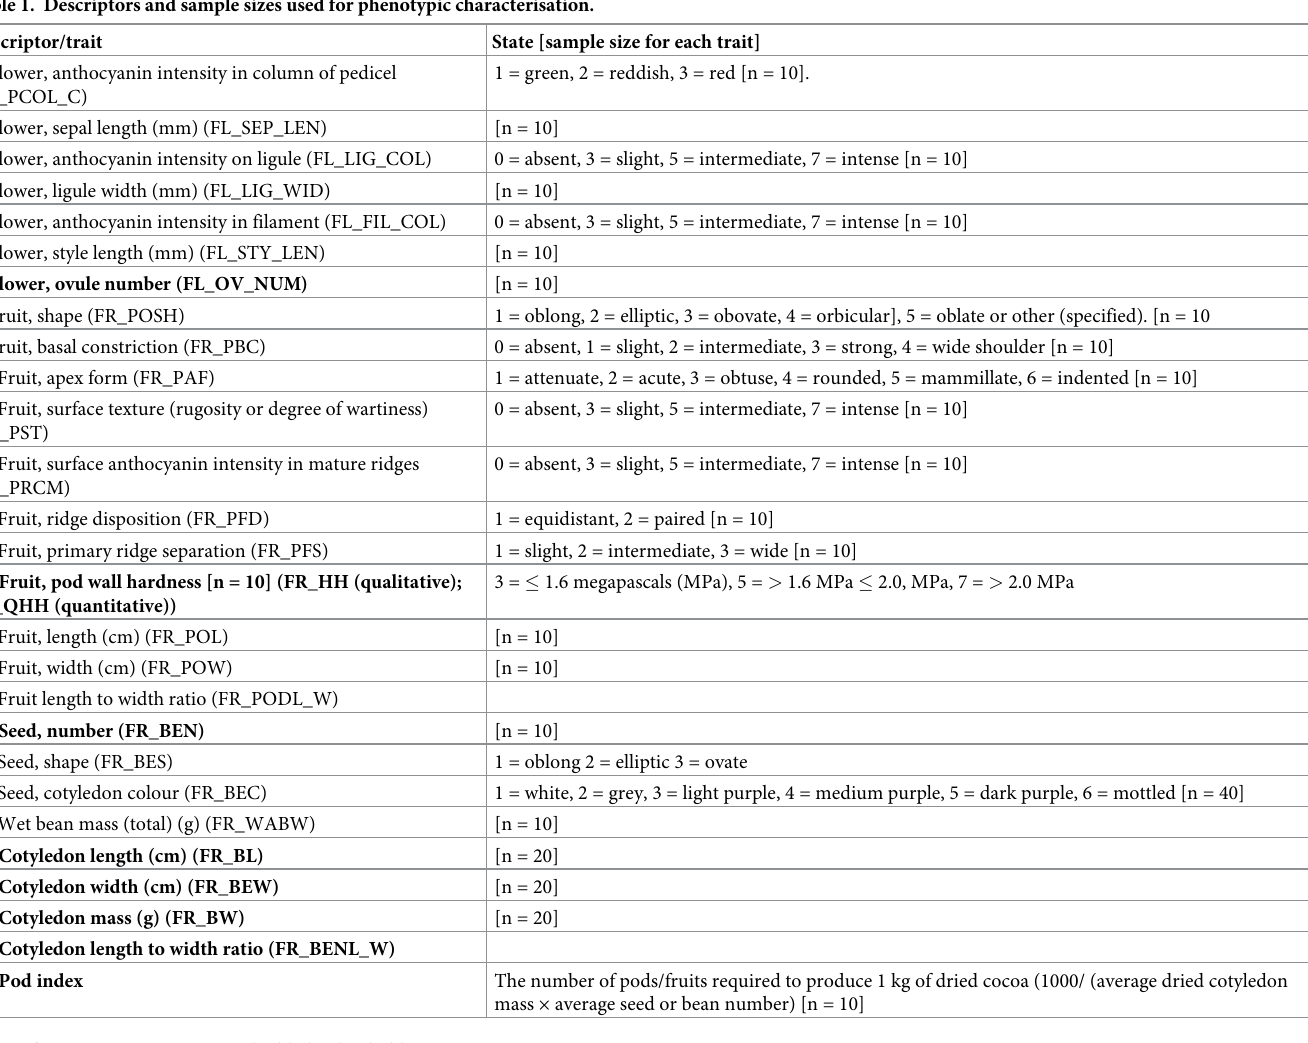
Table 1. Descriptors and sample sizes used for phenotypic characterisation.